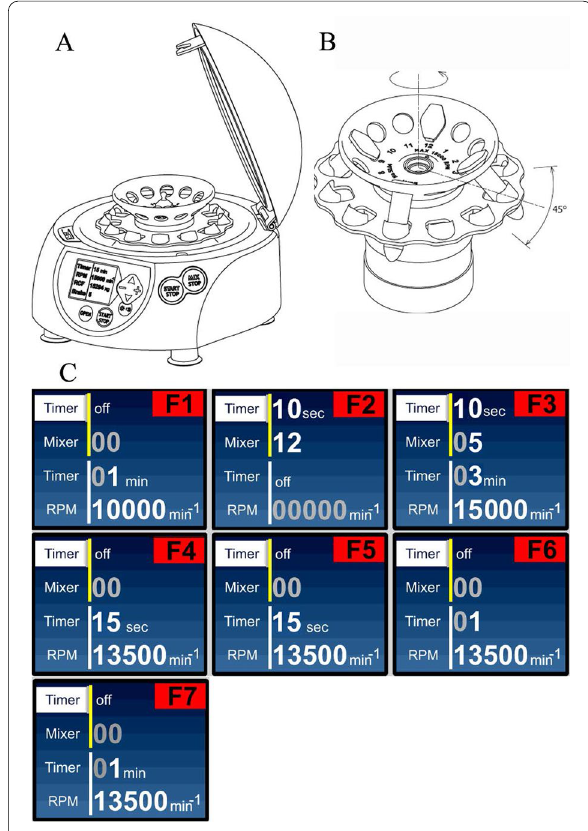
Fig. 1 Schematic view of a miniprep assisting instrument assembly. A Centrifuge/mixer-based apparatus. B Two-part rotor. C F1-F7— steps of the DM miniprep protocol. Pre-set parameters for each step of device-mediated miniprep showing the different settings of parameters such as time and speed of centrifugation (F1, F3–F7), time and intensity of vibration for pellet resuspension (F2) and oscillation frequency of rotor motion at amplitude 45° for liquid mixing (F3). F3 is a step that combines the mixing of the solution by oscillation of the rotor with an oscillation frequency of 400 rpm (Mixer 5) and an amplitude of 45° for 10 s, after which the device automatically starts centrifugation. Amplitude of 45° for liquid mixing is a constant parameter in the DM